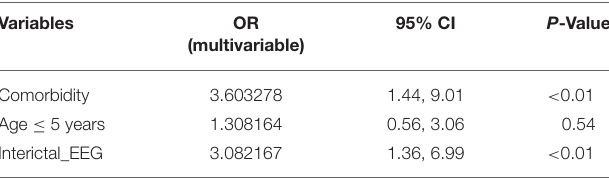
TABLE 3 | Multivariable logistic regression analysis of electroencephalographic (EEG) and clinical findings’ association with abnormal imaging